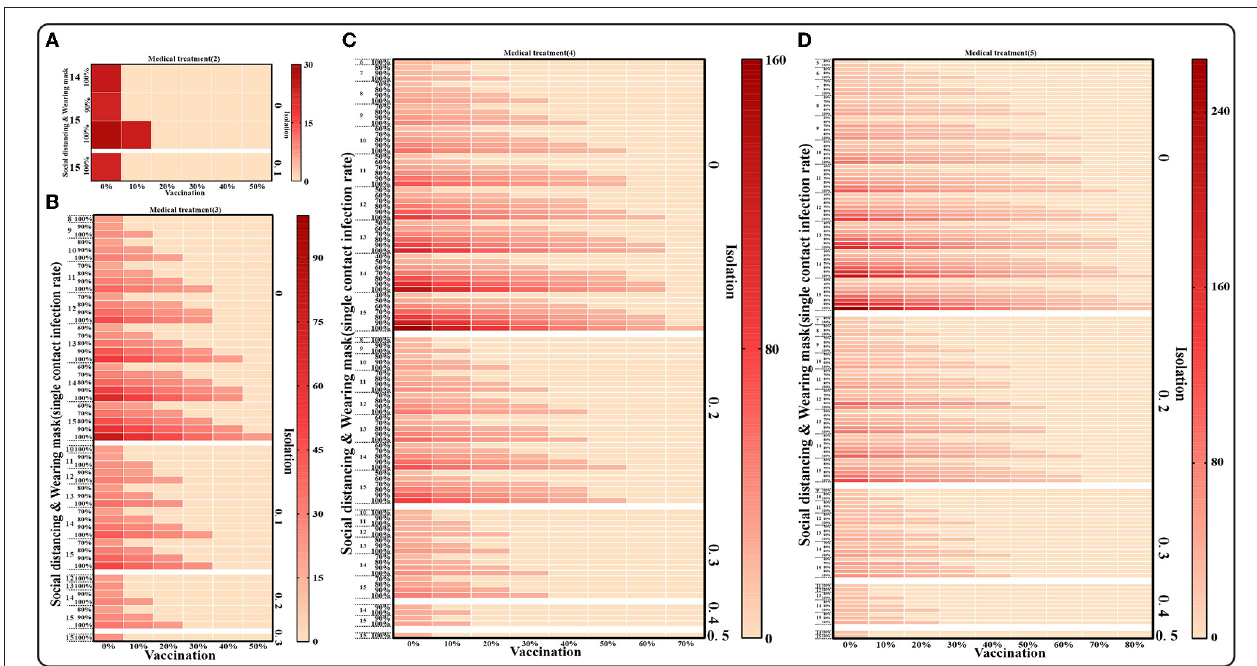
FIGURE 8 | The simulation results of mix of five interventions in Xiamen City, China, 2021. (A) Medical treatment (1/ γ = 2), Isolation ( ϕ = 0,0.1), Social distancing ( x = 14,15), Wearing masks ( q = 100%), Vaccination ( v = 0 ∼ 50%); (B) Medical treatment (1/ γ = 3), Isolation ( ϕ = 0–0.3), Social distancing ( x = 8–15), Wearing masks ( q = 60%–100%), Vaccination ( v = 0 ∼ 50%); (C) Medical treatment (1/ γ = 4), Isolation ( ϕ = 0–0.4), Social distancing ( x = 6–15), Wearing masks ( q = 40%–100%), Vaccination ( v = 0–70%); (D) Medical treatment(1/ γ = 5), Isolation ( ϕ = 0–0.5), Social distancing ( x = 5–15), Wearing masks ( q = 30%–100%), Vaccination ( v =